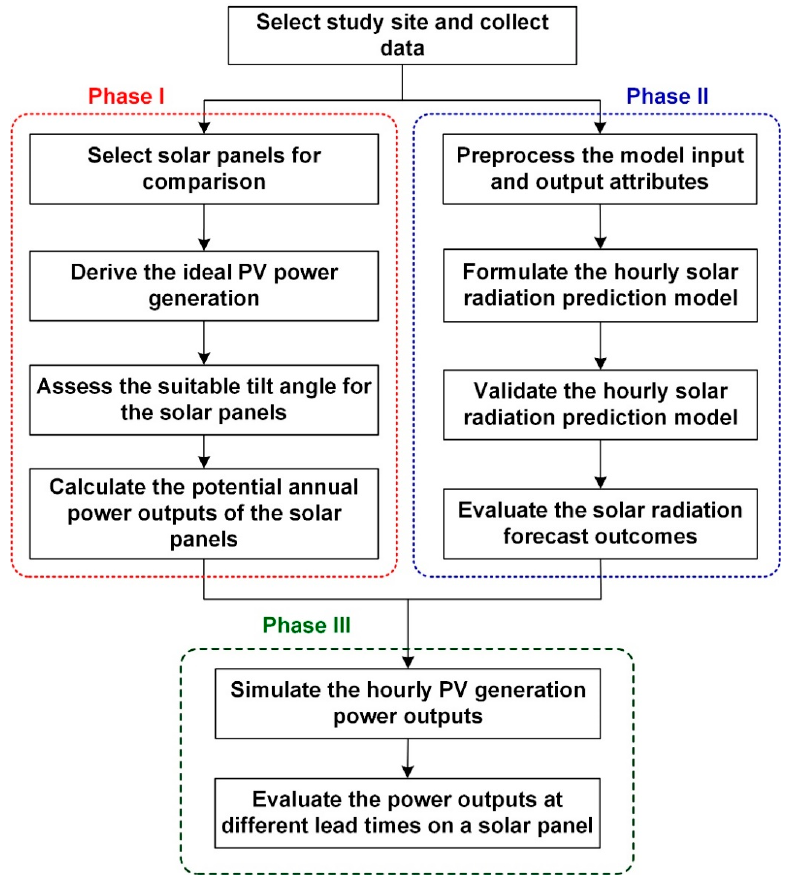
Figure 2. Flow of evaluation of power outputs of a solar panel.